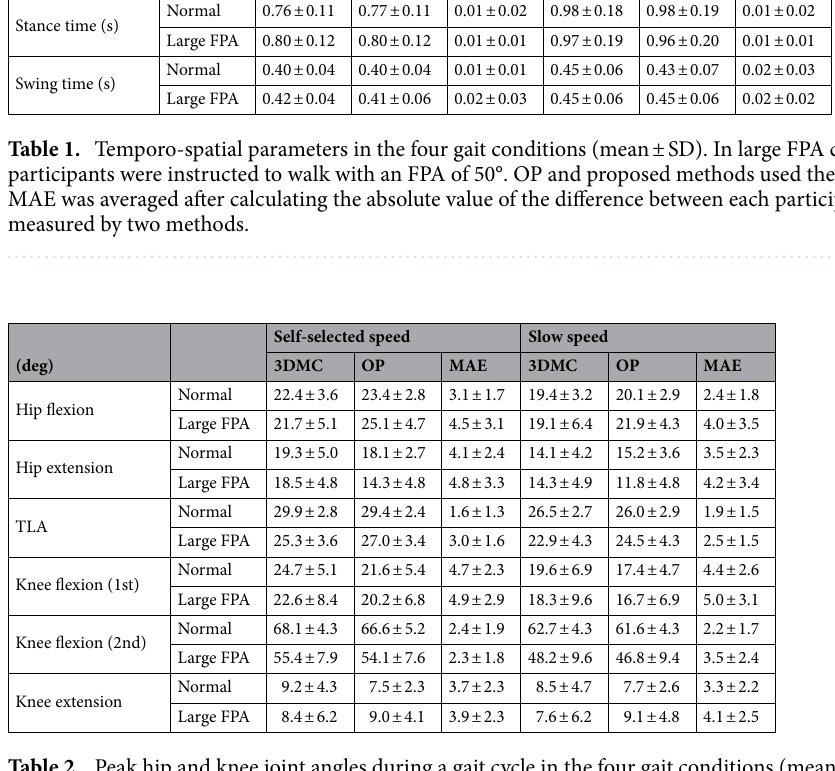
The mean ± standard deviation (SD) of temporo-spatial parameters, hip kinematic parameters, and knee kine- matic parameters under the four conditions are listed in Tables 1 and 2. The OP and proposed methods employed the same calculations for these parameters and so only OP results are shown in Tables 1 and 2. The ankle joint angles of the 3DMC, OP, and proposed methods under the four conditions are listed in Tables 3 and 4. MAE were averaged after calculating the absolute value of the difference between each participant’s data measured by 3DMC and OP or the proposed methods. MAE of lower limb joint angle between the methods was shown in Fig. s1 to s3 (see supplementary material). The MAE in gait speed and stride length under the four conditions were up to 0.02 m/s and 0.06 m, respec- tively. The MAE in stance and swing times were up to 0.02 s (two motion capture frames). Most of the MAE values for these parameters were less than 5% of the 3DMC values. The MAE of gait speed, stride length, stance time, and swing time were not significantly different among the four conditions ( p = 0.290, p = 0.248, p = 0.547, and p = 0.432, respectively). The hip and knee joint angles in the sagittal plane of temporal changes during gait under the four conditions are shown in Figs. 3 and 4. Most of the MAE for hip and knee peak kinematic parameters in each condition were less than 5° (Table 2). The MAE of the peak hip flexion angle and TLA differed significantly among the four conditions (both p = 0.040). Nevertheless, the post-hoc test results did not vary significantly. The MAE of the peak hip extension angle was not significantly different among the four conditions ( p = 0.475). In addition, CCC of the hip and knee joint angles between the 3DMC and OP methods were strongly coupled in each condi- tion (Figs. 3 and 4). Ankle joint angles in the sagittal plane of temporal changes during gait calculated by 3DMC, OP, and the proposed method are shown in Figs. 5. The OP method had substantial peak ankle angle errors under large FPA conditions. In obtaining the MAE between the 3DMC and OP methods, the peak dorsiflexion and plantarflexion